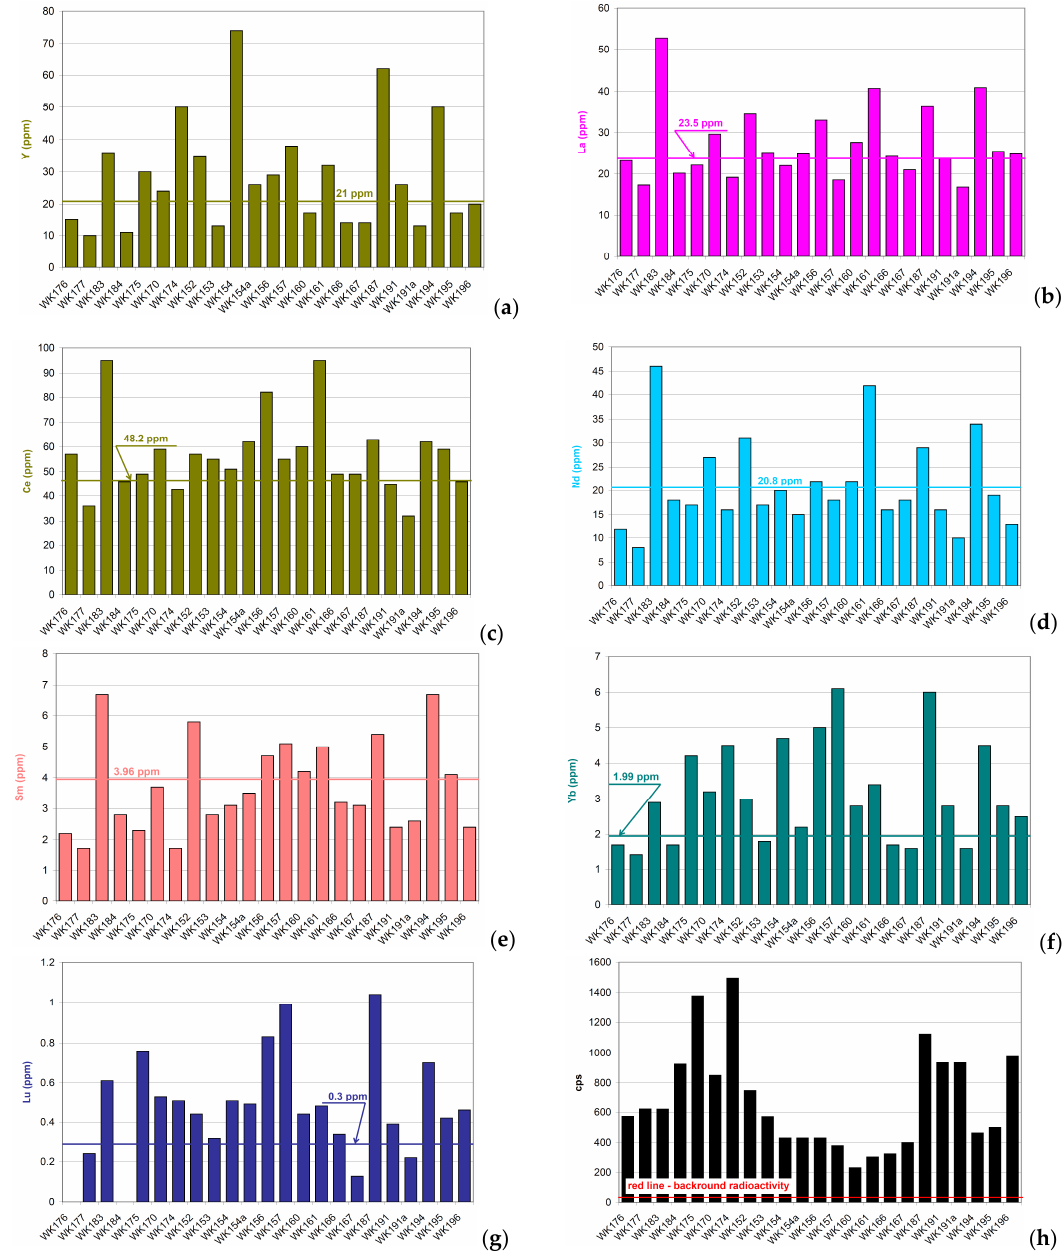
Figure 5. Graphics of grades ( a ) yttrium—Y, ( b ) lanthanum—La, ( c ) cerium—Ce, ( d ) neodymium—Nd, ( e ) samarium—Sm, ( f ) ytterbium—Yb, ( g ) lutetium—Lu and ( h ) radioactivity in counts/sec (cps). The highest concentration of barium (Ba) was measured at point WK183 (Table 1), Delgerhid block, at the contact between Quaternary and Lower Cretaceous sediments. The concentration was Table 1. The highest values determined from sample points and areas. 5040 ppm (Figure 4a) and the sample was a light grayish-brown carbonaceous conglomerate with loose pebbles (Figure 6a). The radioactivity was 620 cps. The average concentration in Regional European Studies (RES) in soil is 500 ppm